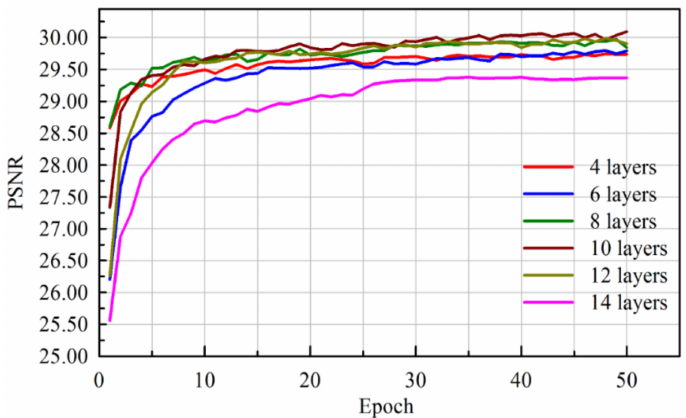
Figure 6. PSNR values on the validation set during training with different depths of layers.